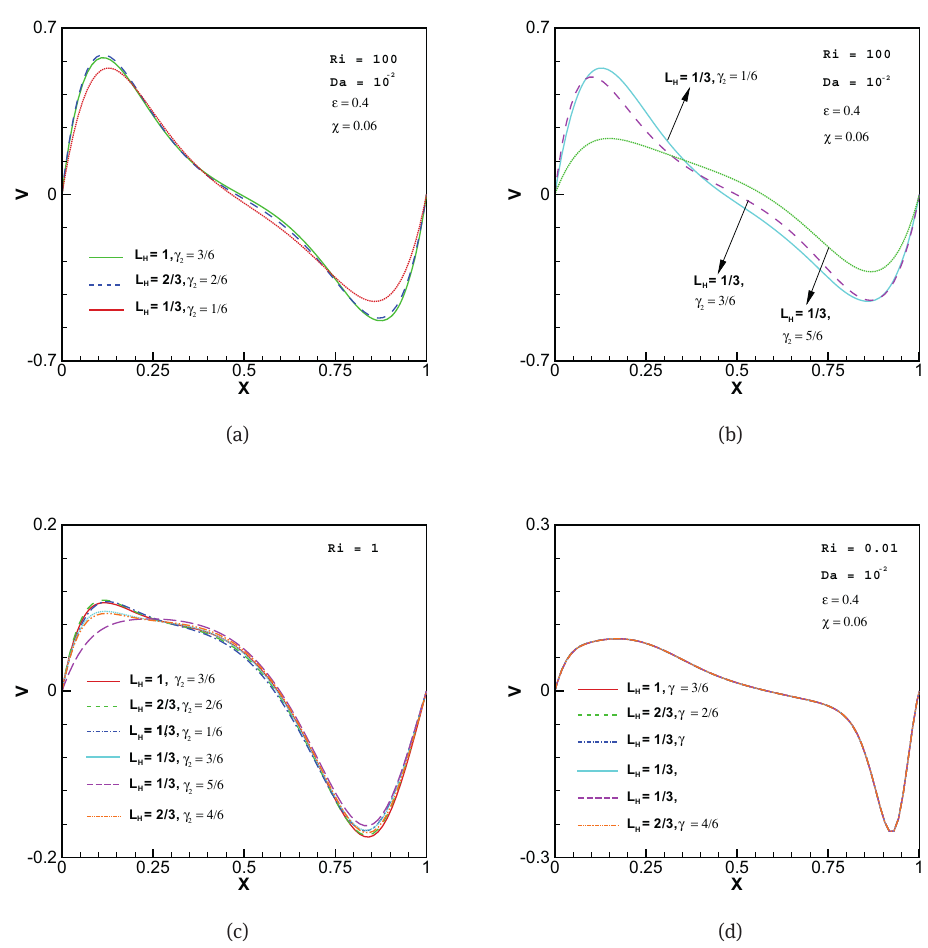
Fig. 7: V- velocity profiles at mid-plane of the cavity for different L H and γ 2 at (a-b) Ri = 100 , (c) Ri = 1 , (d) Ri=0.01.